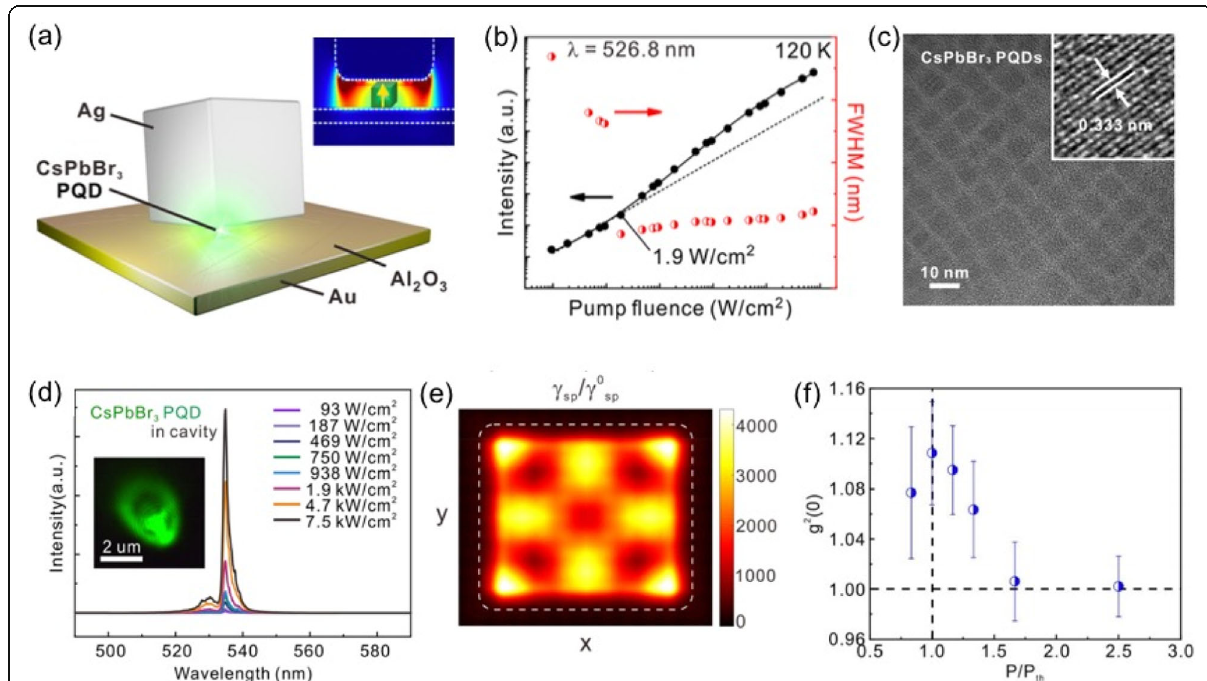
Fig. 2 a - e Schematic, lasing signatures, and the lasing mechanism of a single perovskite quantum dot (PQD) in a gap plasmon nanocavity at 120 K. f The temporal coherence signature of the PQD nanolasing under 120 K was